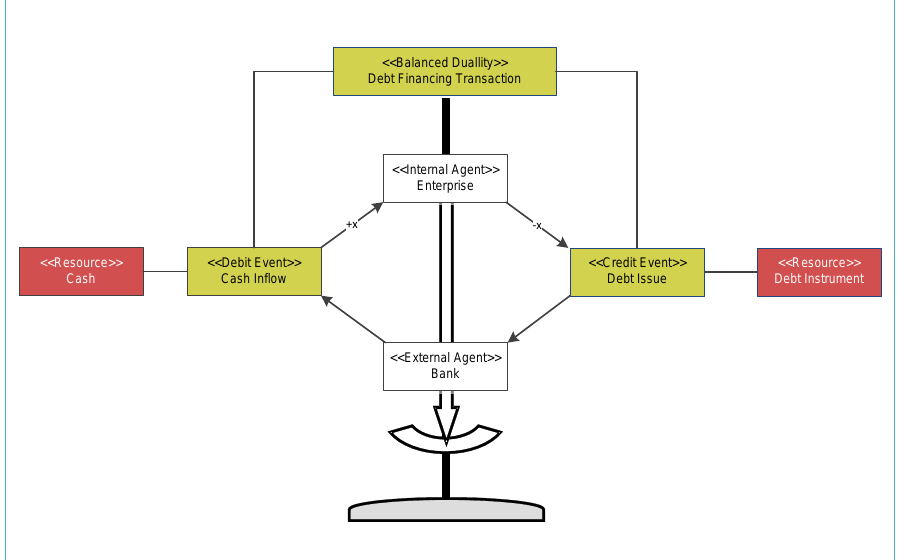
Figure 9 . Balanced Duality relationship – debt financing